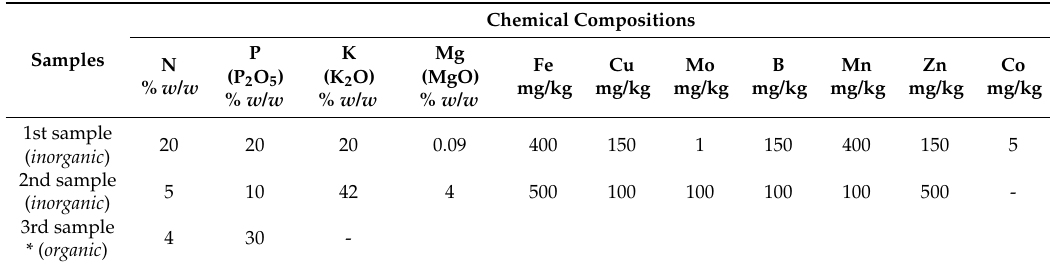
Table 3. Nutritional content of the three fertilizer samples.